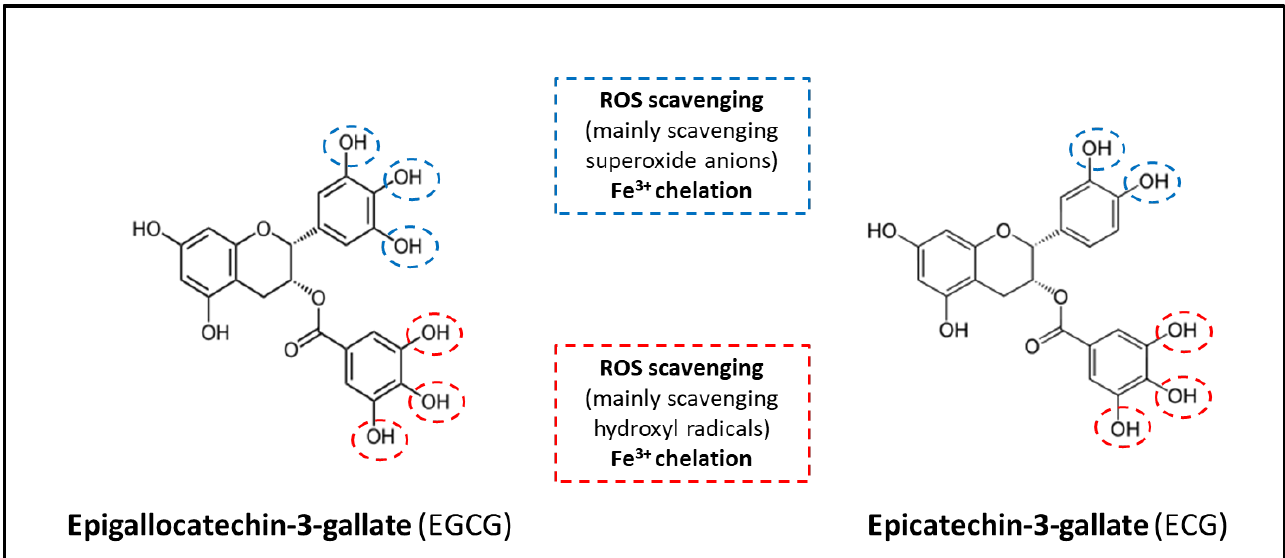
Figure 2. The biochemical structures of epigallocatechin-3-gallate (EGCG) and epicatechin-3-gallate (ECG) in relation to some of their antioxidant actions [51,52,54,55].